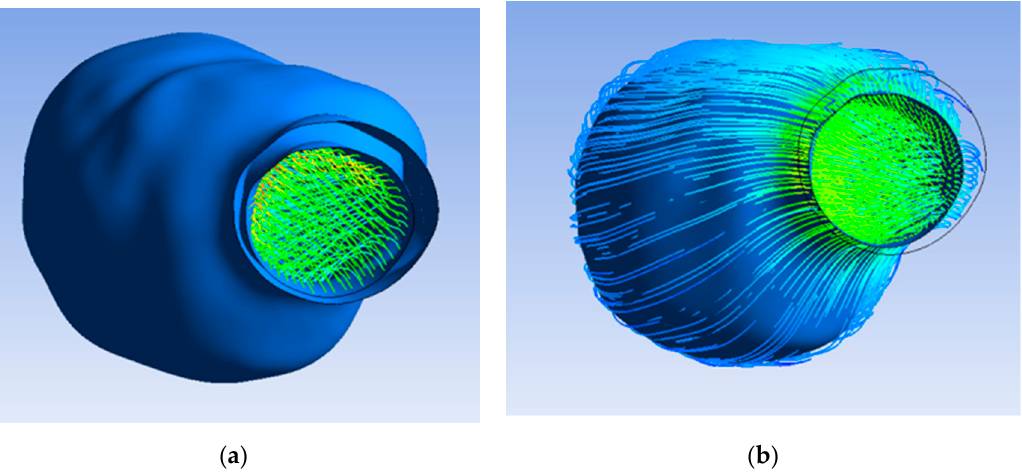
Figure 5. ( a ) Inner ILT surface and aneurysm wall; ( b ) flow pattern inside lumen. The flow pattern inside the lumen and ILT after applying porosity with a permeability value of 3.7 × 10 − 7 m 2 is illustrated in Figure 5b, which indicates the flow of blood and oxygen penetrating the ILT surface due to the porous property applied on the ILT. Figure 6 shows that the flow did not penetrate the aneurysm wall, as it was impermeable.